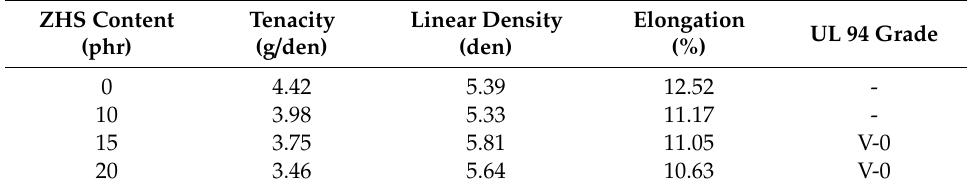
Table 1. Mechanical properties and results of the vertical burning test (UL94) of PANVDC according to ZHS content.